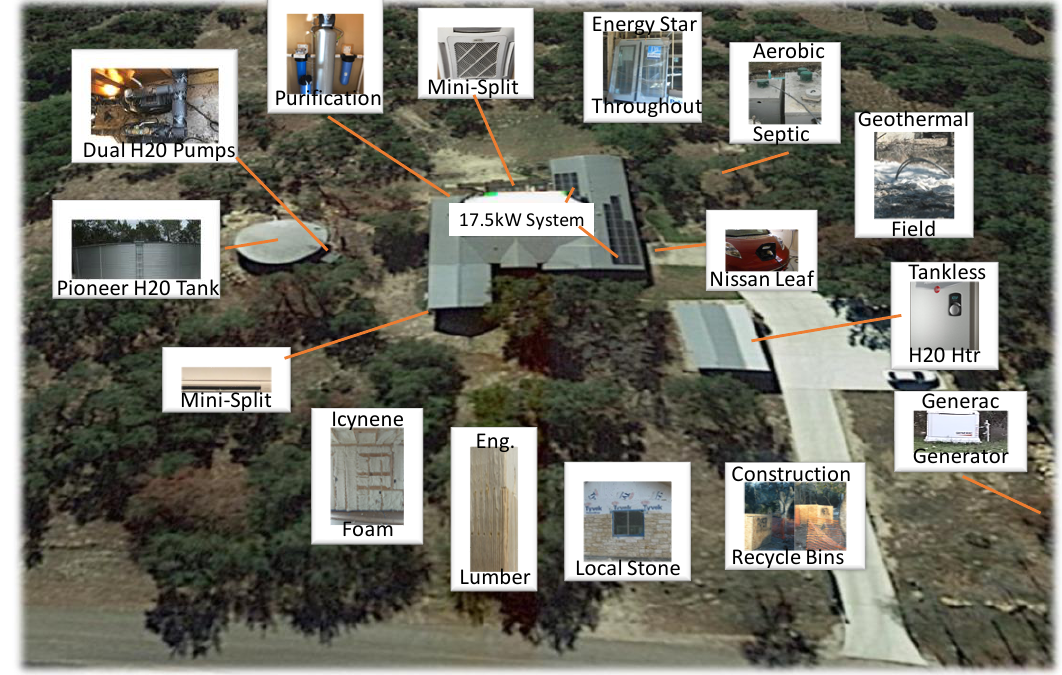
Figure 4. The residence as constructed.